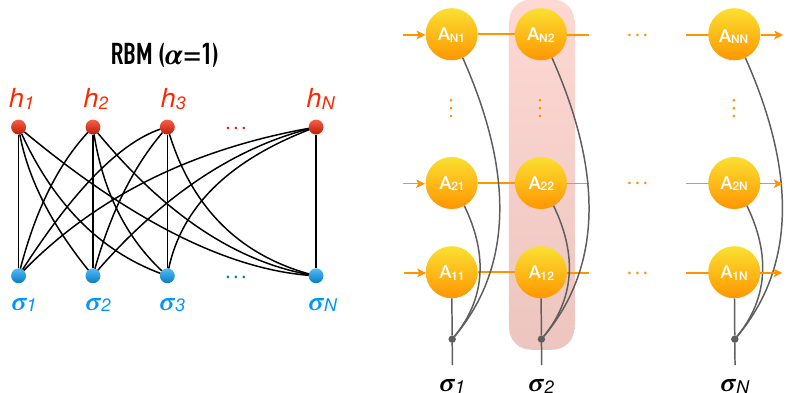
Figure 1: The RBM for α = 1 ( M = N ) (left) can be mapped to an exponentially large coMPS (right). The pink-shaded region represents the 2 N × 2 N local matrix Σ which is constructed as a tensor product of N matrices (yellow circles) with bond dimension χ = 2 (see main text for details). Arrows indicate periodic boundary